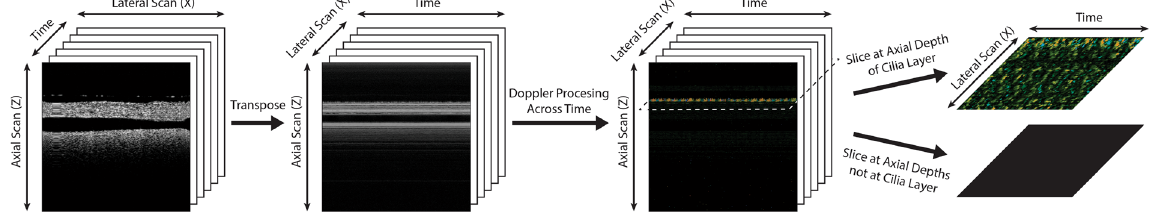
Figure 2. Processing flowchart for calculating CBF using Doppler OCT. The M-mode slice at the cilia layer will show the induced phase shift from ciliary motion while all other layers will have very low phase signals. The axial scan direction (Z) refers to the propagation direction of the scanning light into the cilia sample while the lateral scan (X) is parallel to the surface of the